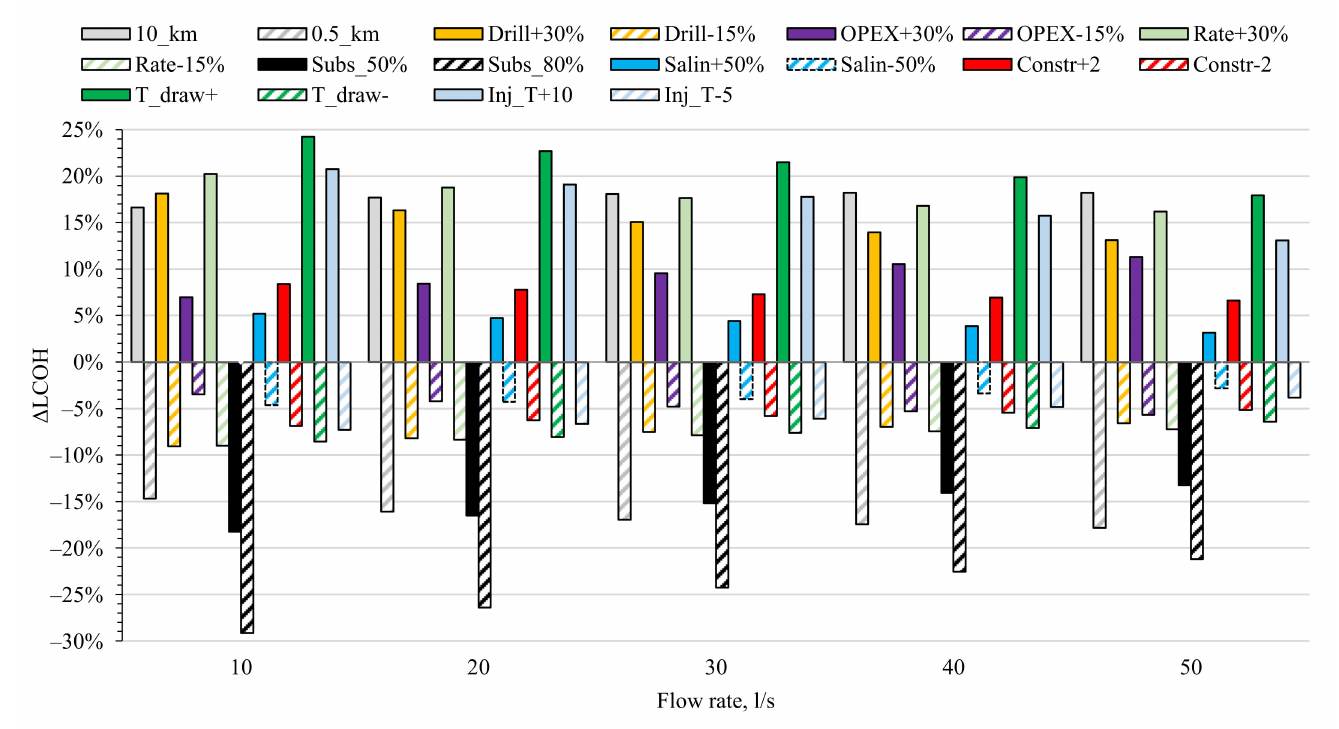
Figure 8. LCOH sensitivity analysis for the parameters from Table 1.